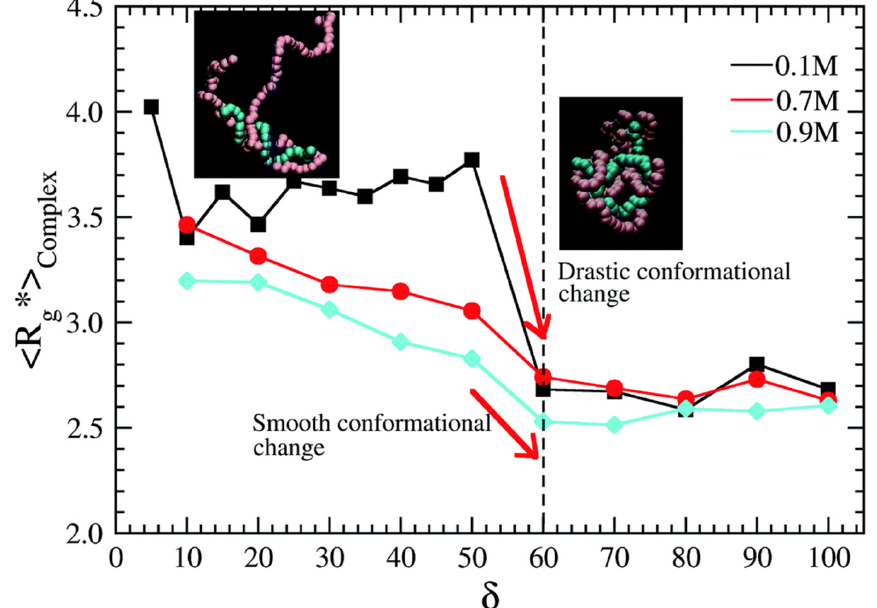
Figure 6. Radius of gyration of the complex as a function of PSS − size and ionic strength of the solution. The vertical dotted line indicates the ratio at which a change from an extended to a compact complex structure appears for the systems with 0.1 M of NaCl. The arrows indicate the regions of crossover from a drastic to a smooth conformational change. The insets on the left and right show the polyelectrolyte complex for δ = 30% and 60%, respectively, at 0.1 M NaCl concentration. (Repub-